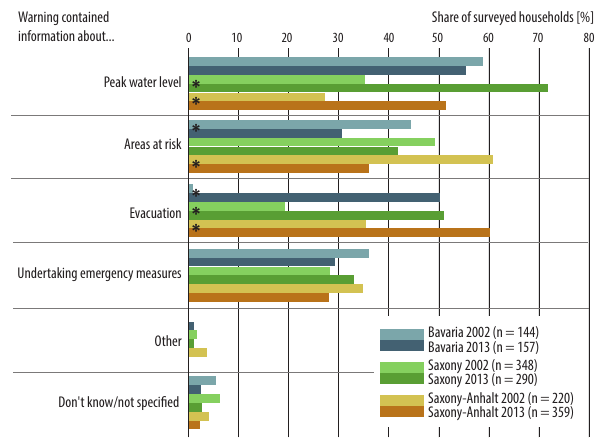
Figure 4. Information content of official flood warnings received by private households in Bavaria, Saxony and Saxony-Anhalt ( ∗ indi- cates significant differences ( p <0.05) between 2002 and 2013).